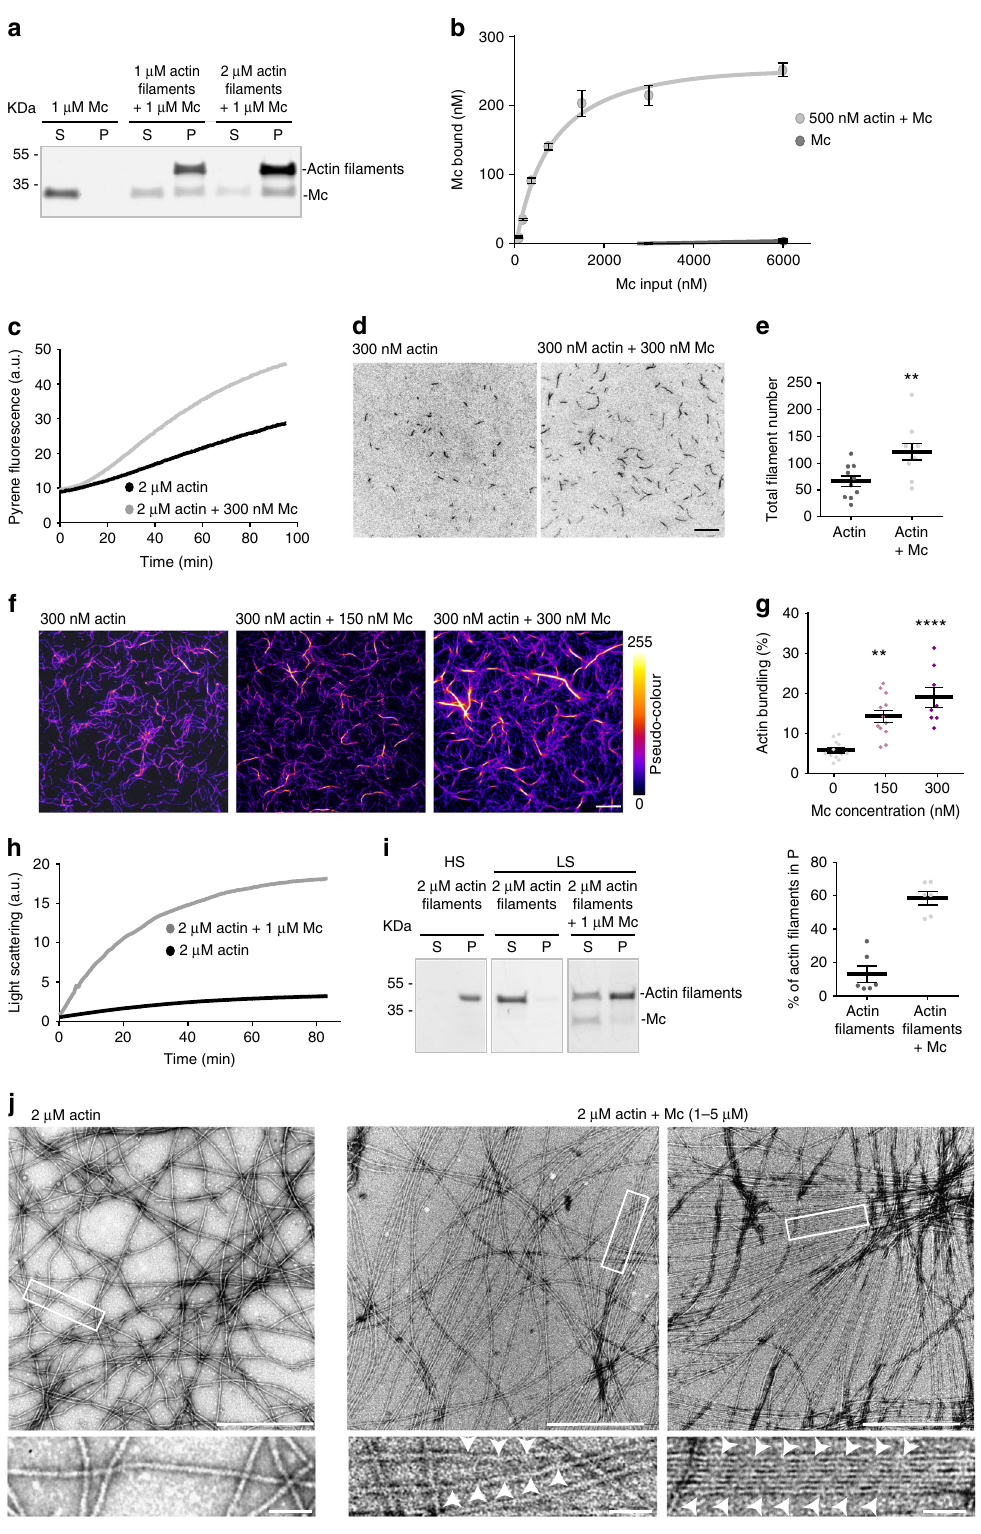
modelling indicates that morphogenesis of the spine head can be quantitatively accounted for by a balance of forces, involving a combination of actin bundles pushing outward along the axis of the spine neck, and fi laments that emerge from Arp2/3-nucleated branches and that exert isotropic radial pressure in the head 45